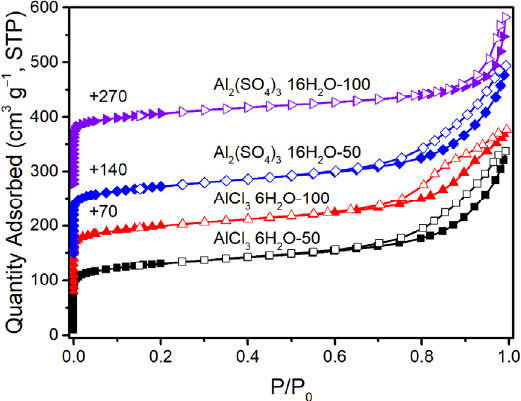
Figure 8. N 2 physisorption isotherms of ZSM ‐ 5 with Si/Al ratios of 50 and 100 synthesized with different Al sources.